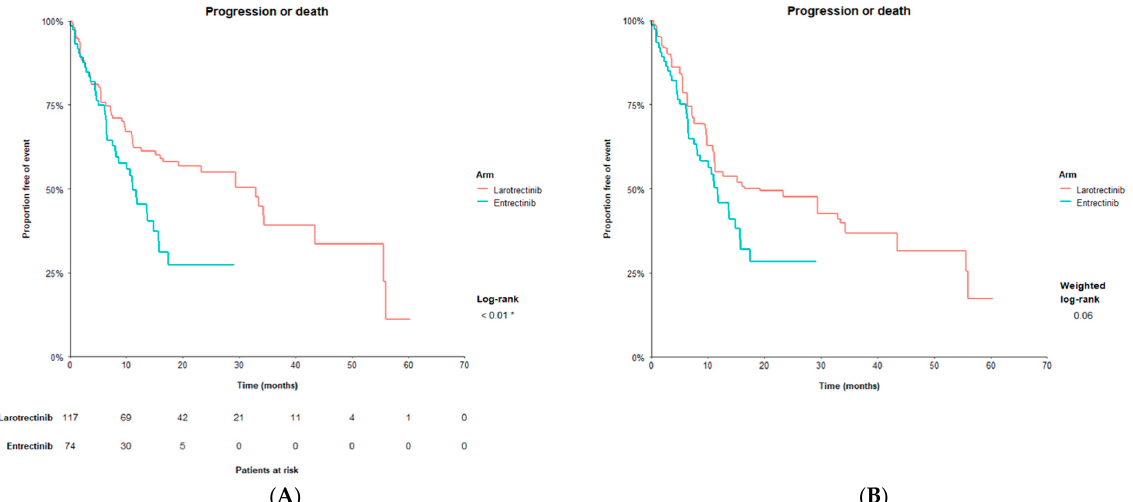
Figure 2. Progression-free survival with larotrectinib vs. entrectinib. ( A ) Kaplan–Meier curve for progression-free survival before matching. ( B ) Kaplan–Meier curve for progression-free survival after matching on primary matching factors a . Notes: a. Primary matching variables include the